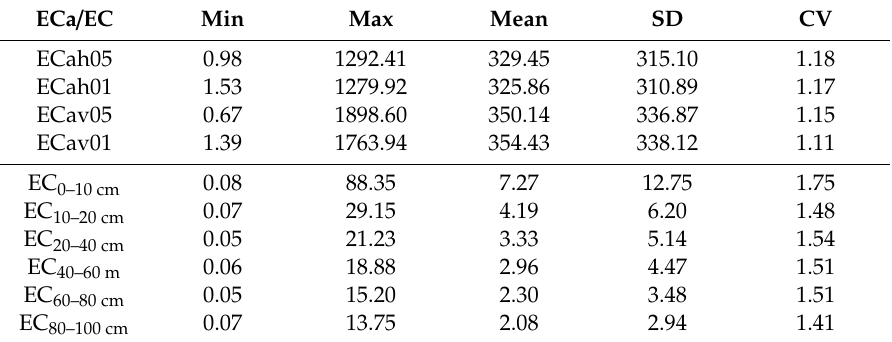
Table 2. Statistical summary of the four ECa coil configurations and electrical conductivity (EC) at six depths. ECa / EC Min Max Mean